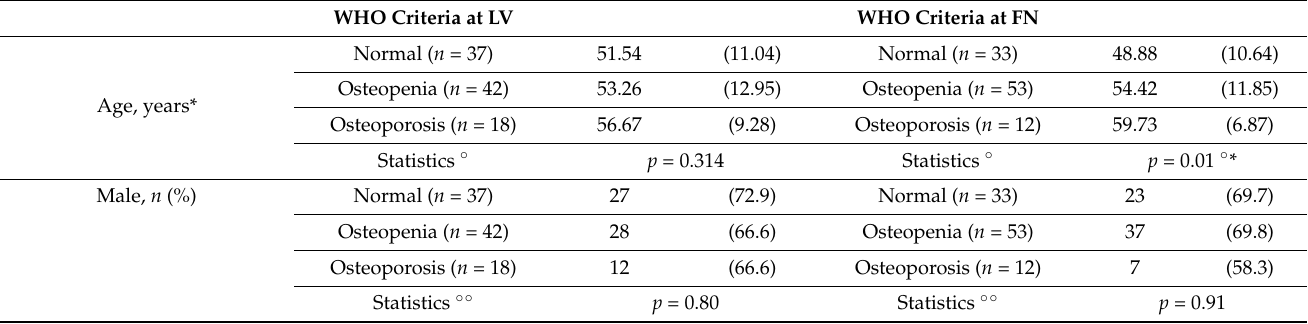
Table 3. Relationship of demographic and biochemical data with bone mineral density status at lumbar vertebral bodies (LV) and right femoral neck (FN). WHO Criteria at LV WHO Criteria at